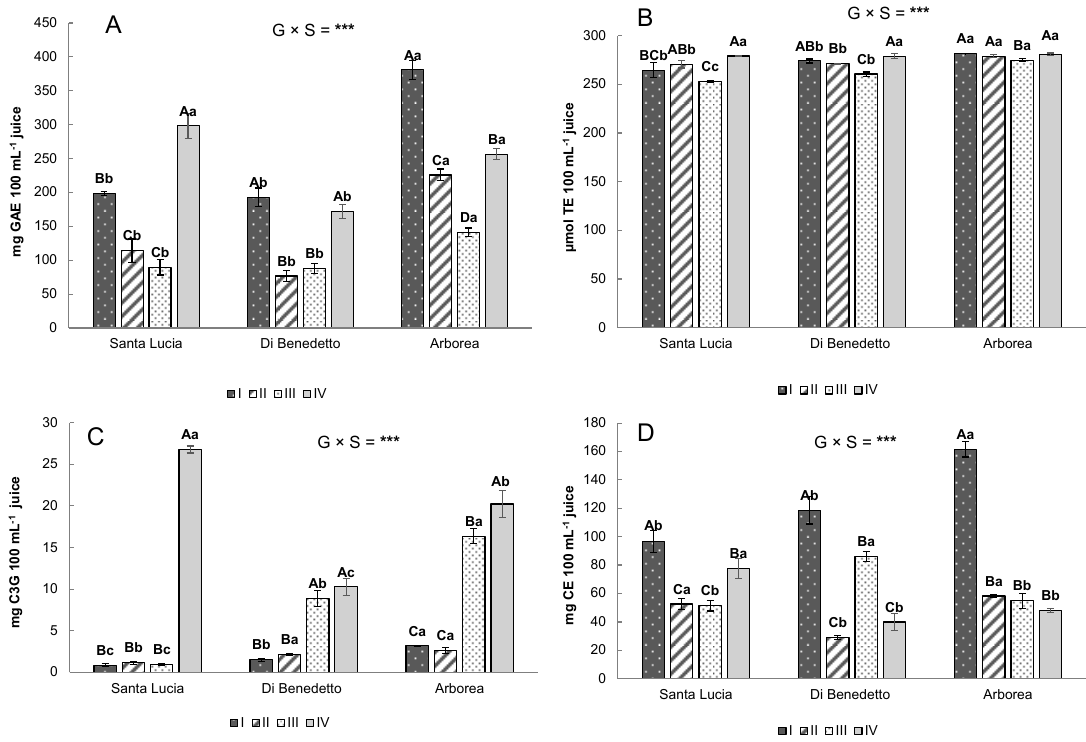
Figure 2. Total polyphenol ( A ), DPPH—antioxidant activity ( B ), anthocyanin content ( C ), and flavonoid content ( D ) of three pomegranate accessions (‘Santa Lucia’, ‘Di Benedetto’, and ‘Arborea’) during I–II–III–IV ripening stages. All the data are expressed as mean ± SE (standard error). Different uppercase letters indicate significant differences during ripening stages in the same accession, and different lowercase letters indicate significant differences in the same ripening stages for the three accessions, in accordance with Duncan’s multiple range test ( p = 0.05). Levels of significance for the two-way ANOVA (Genotypes (G) × Stages (S)) are indicated as *** ( p <